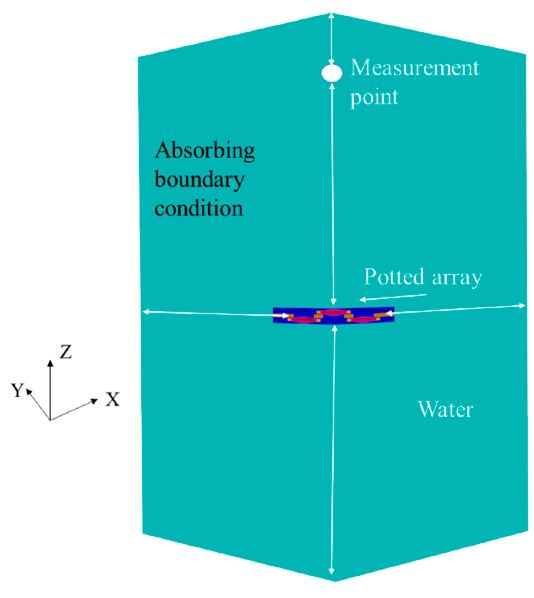
Figure 3. FEA model of the immersed cymbal array.